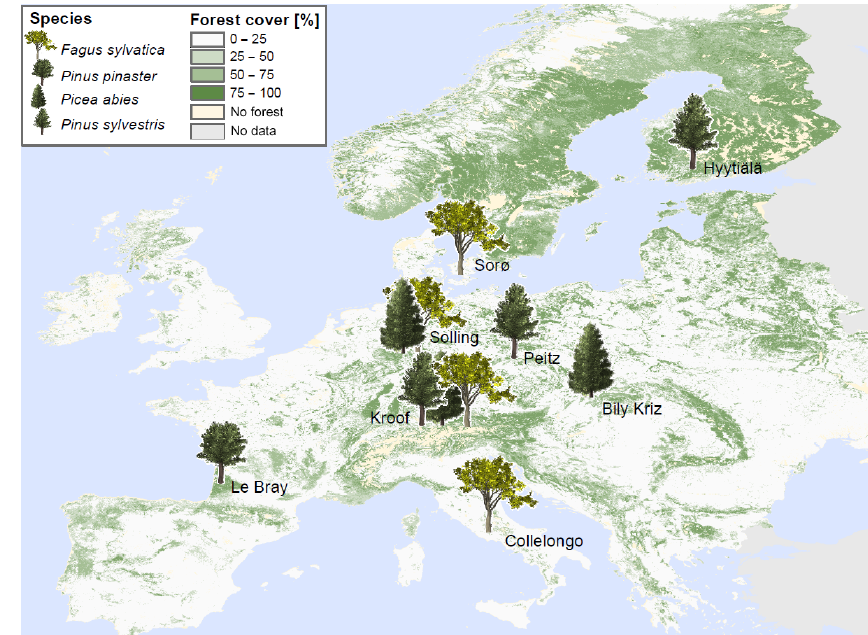
Figure 1. Location of forest sites and main tree species. Background shows the European forest cover after Brus et al.